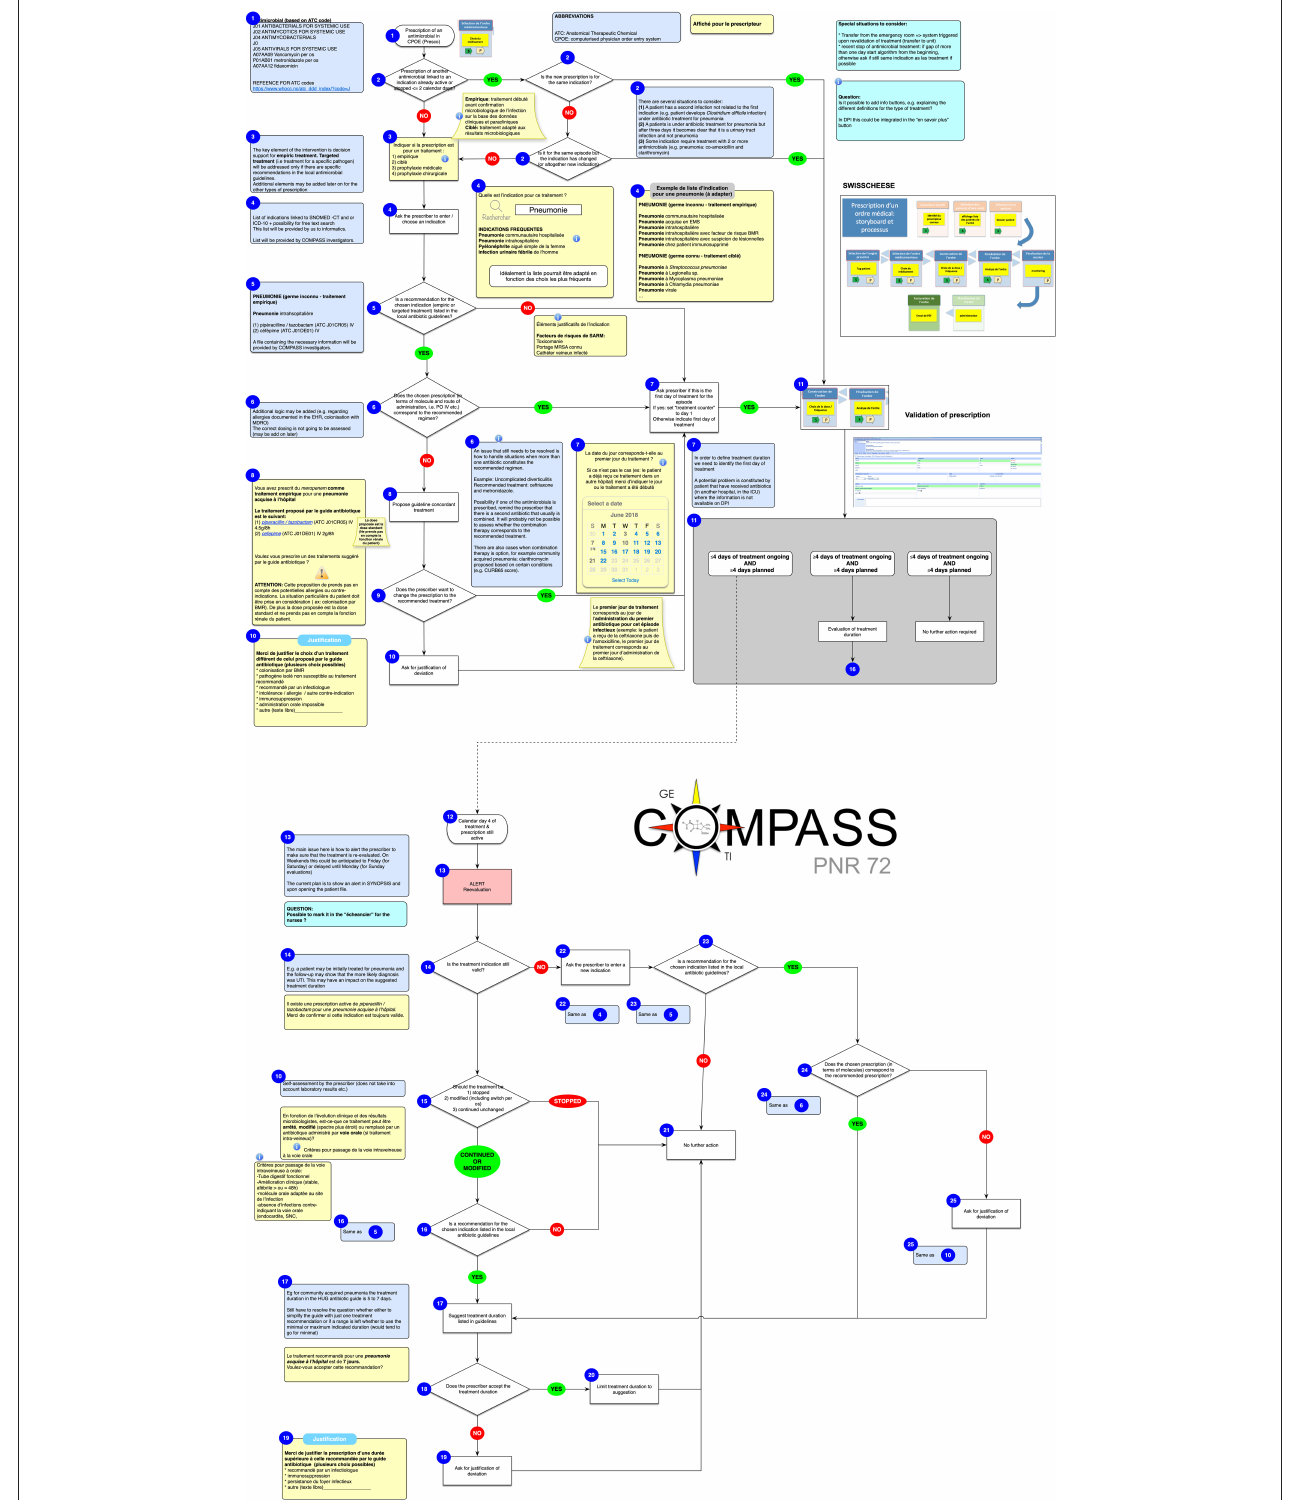
FIGURE 1 | (A) Workflow and rules of the COMPASS algorithm drawn in collaboration with business modelers. (B) Workflow and rules of the COMPASS algorithm initially drawn by the PI.